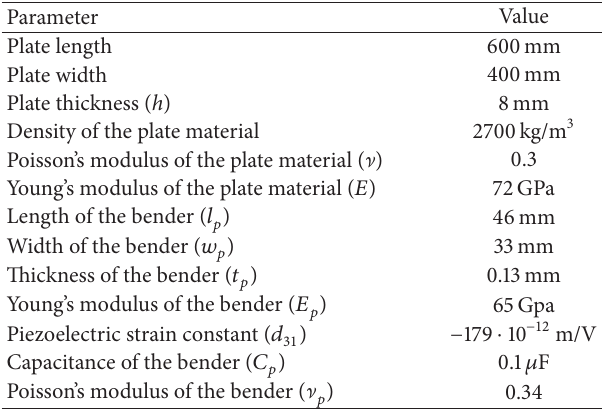
Table 6: Test setup nominal